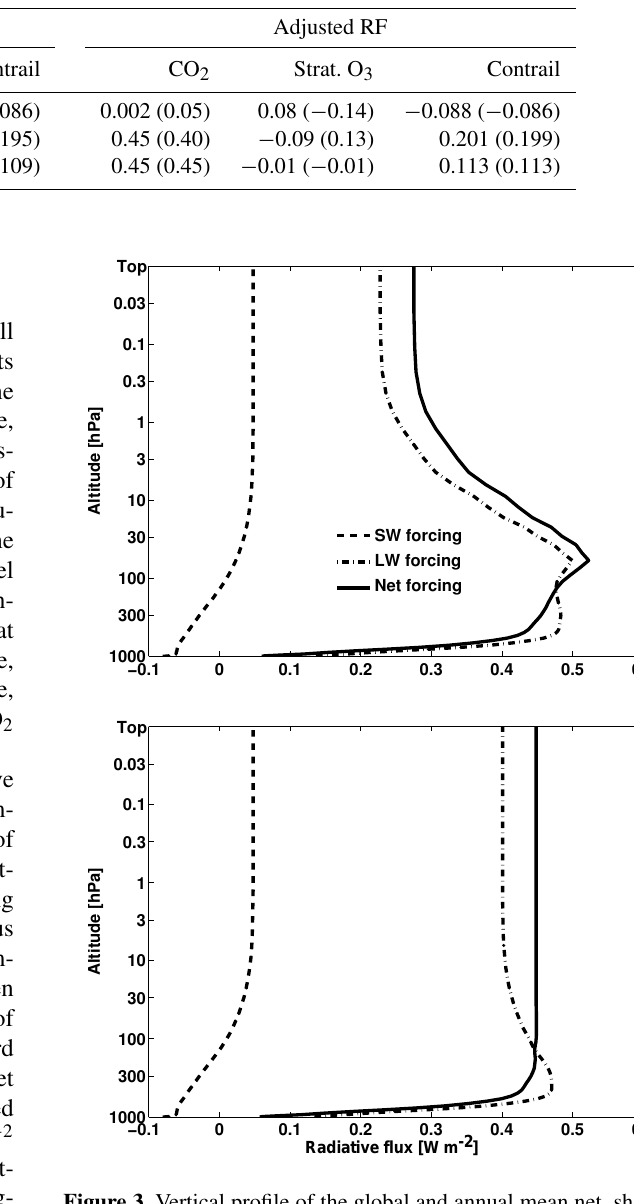
Figure 3. Vertical profile of the global and annual mean net, short- wave, and longwave instantaneous radiative flux change (top) and of the stratosphere-adjusted radiative flux change (bottom) in Wm − 2 , resulting from CO 2 change between 1980 and